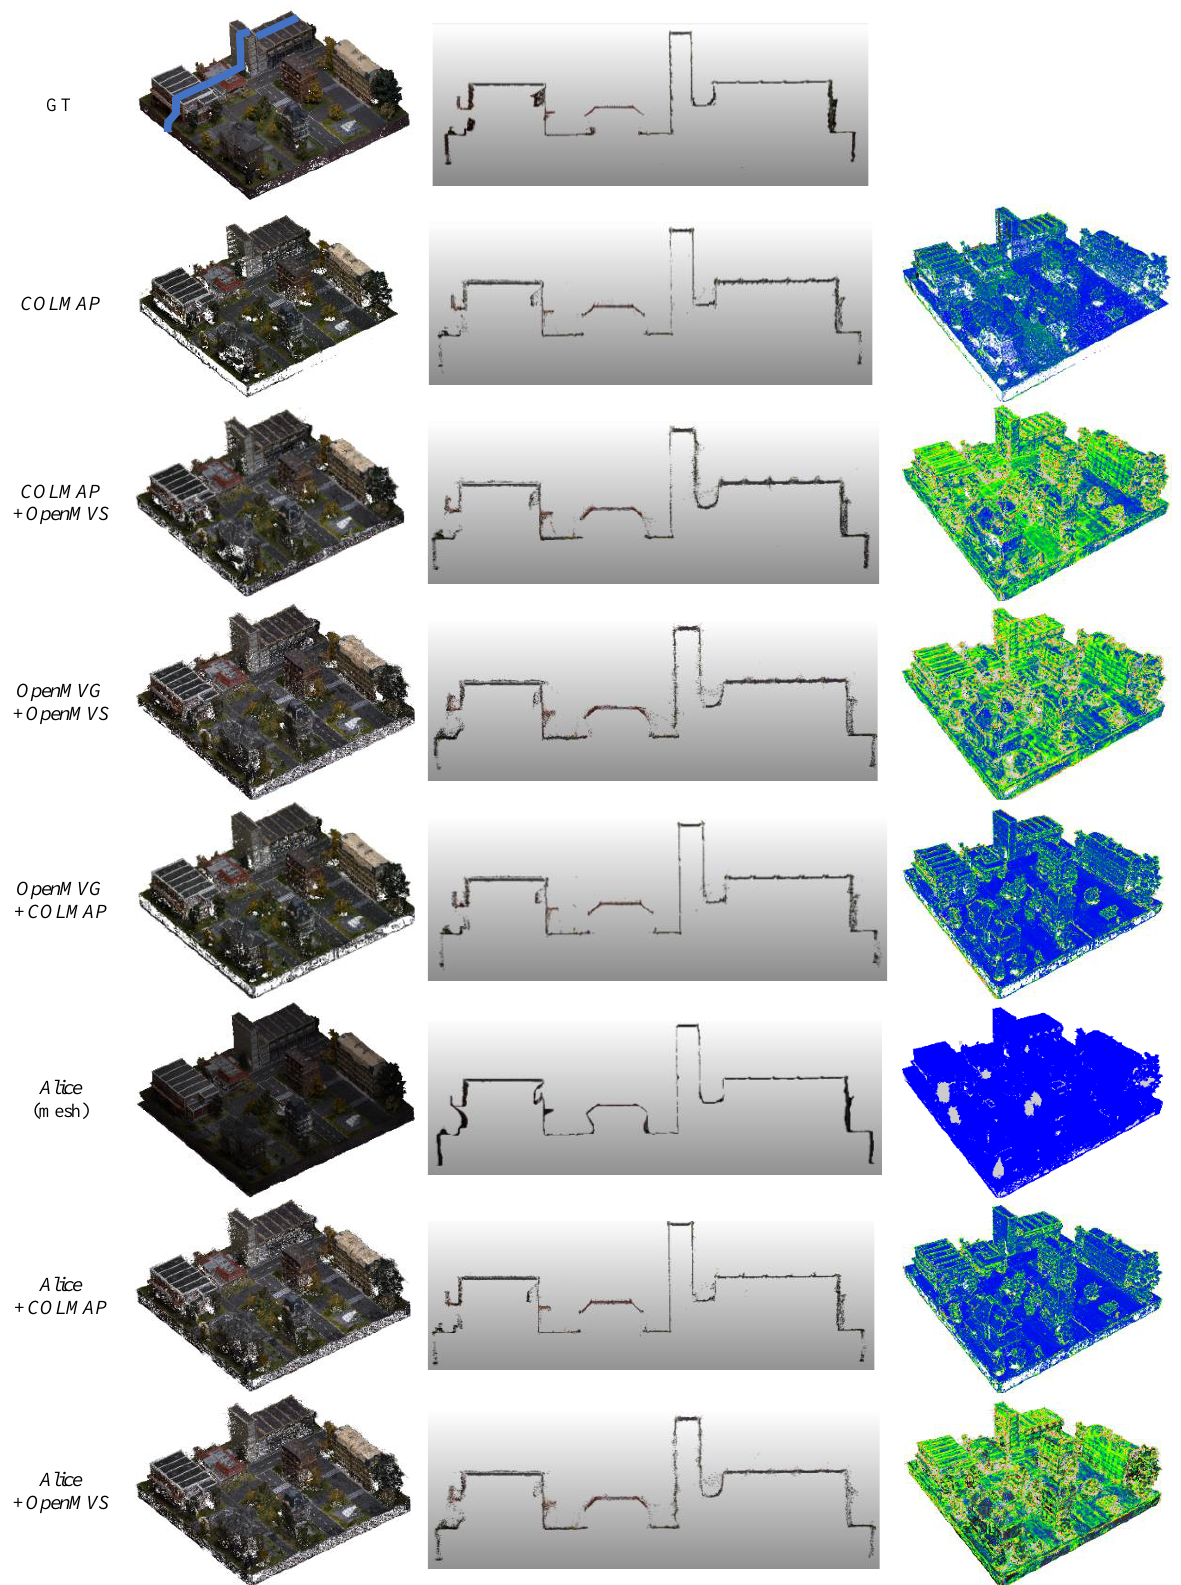
Figure 3. 3DOMcity dataset: derived dense point clouds, corresponding cross-sections and C2C/C2M distances (scale: 0(blue)- 5(red) mm) with respect to the GT data for COLMAP , COLMAP+OpenMVS , OpenMVG+OpenMVS , OpenMVG+COLMAP , Alice , Alice+COLMAP , Alice+OpenMVS , respectively from top to